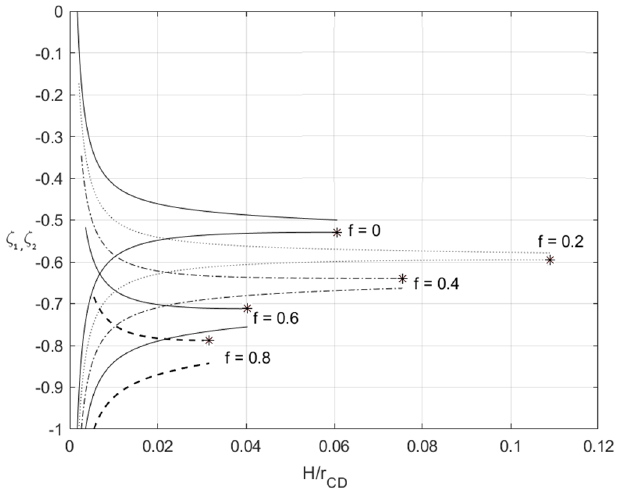
Figure 2. Illustration of the solution nonexistence conditions following from Equation (60) at β = 5 and several values of f .